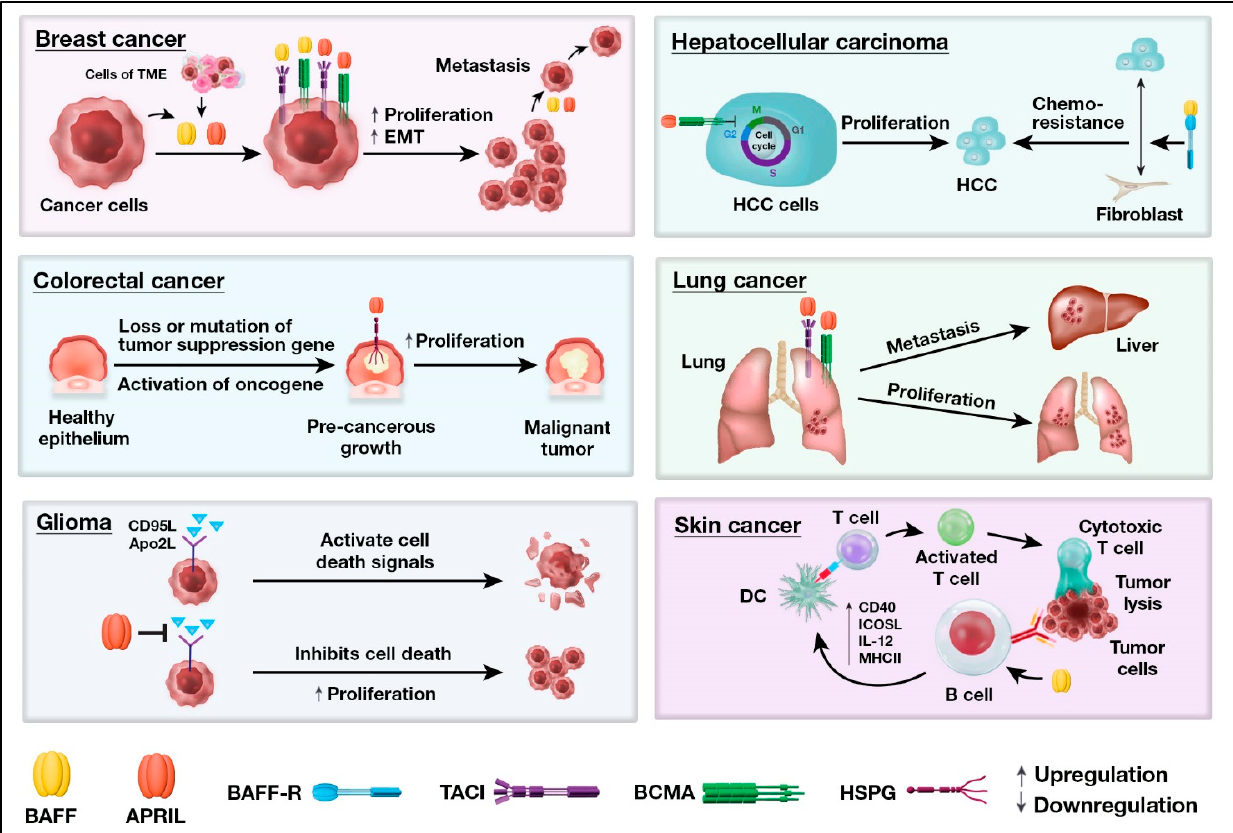
Figure 3. Role of the BAFF ‐ APRIL system in the development of solid cancers. Dysregulated BAFF ‐ APRIL signaling primarily contributes to the proliferation and survival of solid tumors, outlined in this schematic. The mechanisms of action are described in the relevant sections. Abbreviations: TME = tumor microenvironment; HCC = hepatocellular carcinoma. ↑ refers to upregulation and ↓ refers to downregulation.